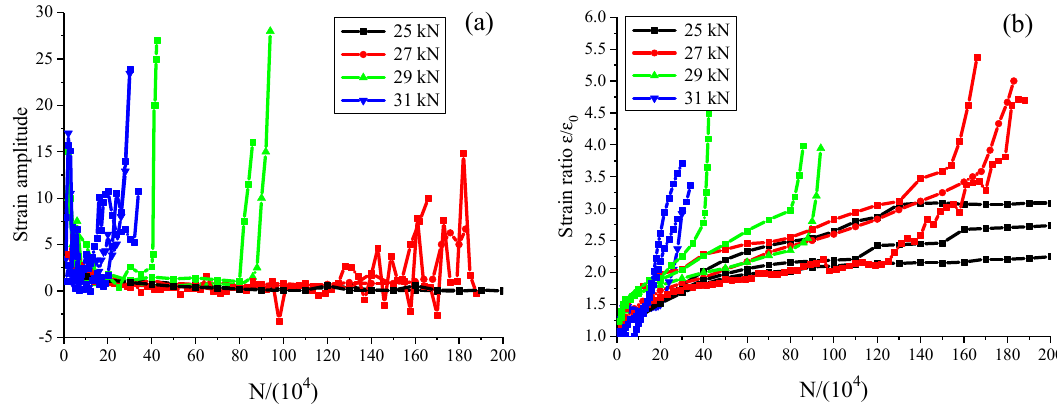
Figure 17. Strain evolutionary characteristic: ( a ) Strain increment ; ( b ) Strain ratio .